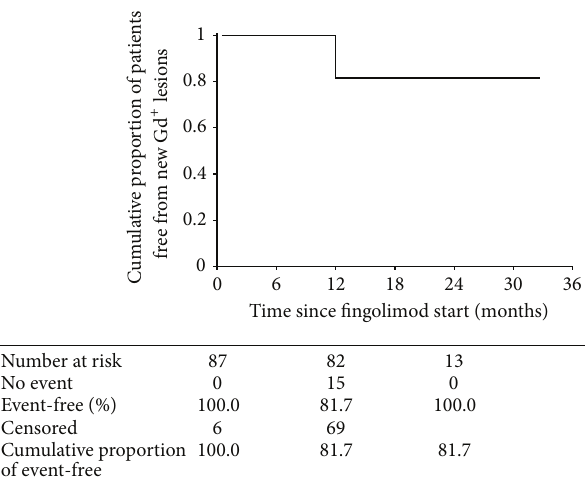
Figure 5: Kaplan-Meyer plot of cumulative proportion of patients remaining free from new gadolinium enhancing (Gd + ) lesions at magnetic resonance imaging over time from start of fingolimod therapy.